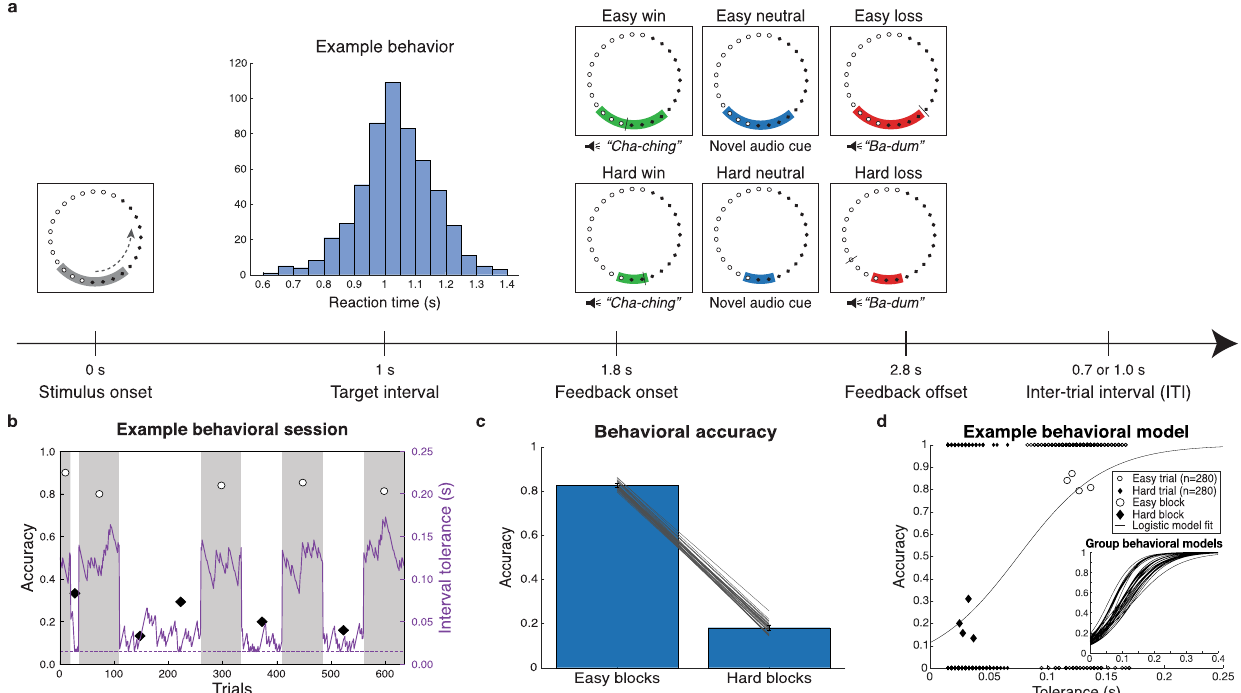
Fig. 1 Task design, performance, and behavioral modeling of prediction errors. a Participants pressed a button timed to the estimated completion of lights moving around a circle. The gray target zone cue displayed error tolerance around the 1 s target interval. An example participant RT distribution is centered at the target interval. Audiovisual feedback is indicated by the tolerance cue turning green for wins and red for losses. A black tick mark displayed RT feedback. On 12% of randomly selected trials, blue neutral feedback was given with no RT marker. b Example recording session for one participant for training ( fi rst 35 trials) and experimental blocks. Staircase adjustments of tolerance are plotted as a solid purple line, and the dotted purple line indicates the minimum bound on tolerance at ±15 ms. Accuracy for easy and hard blocks is plotted as white circles on gray backgrounds and black diamonds on white backgrounds, respectively. c Separate staircase procedures resulted in group accuracies of (mean ± SD) 82.7 ± 1.7% for easy and 18.1 ± 2.5% for hard blocks. Error bars indicate standard deviation across participants, with individual participant ( n = 32 participants) accuracy overlaid as gray lines. d Tolerance and outcome data for the same example participant. Larger markers show block-level accuracy; smaller markers show binary single-trial outcomes. Model fi t using logistic regression provides single-trial estimates of win probability, which can be converted to expected value. Inset shows win probability curves across all 32